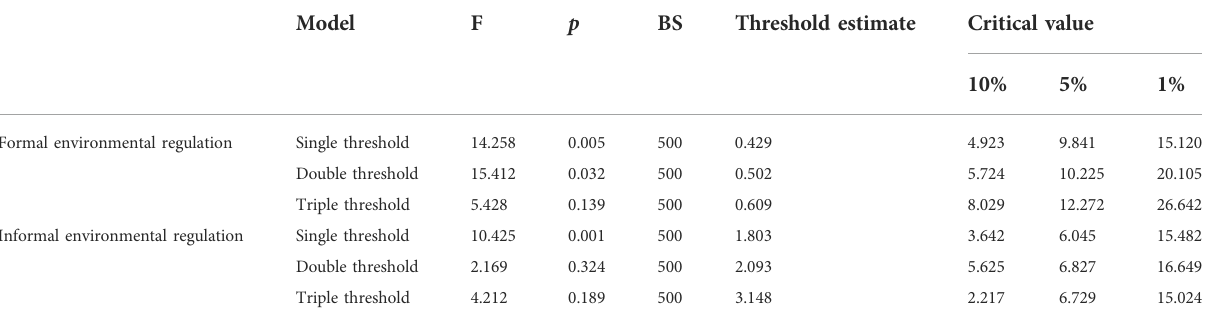
TABLE 6 Signi fi cance test results of threshold